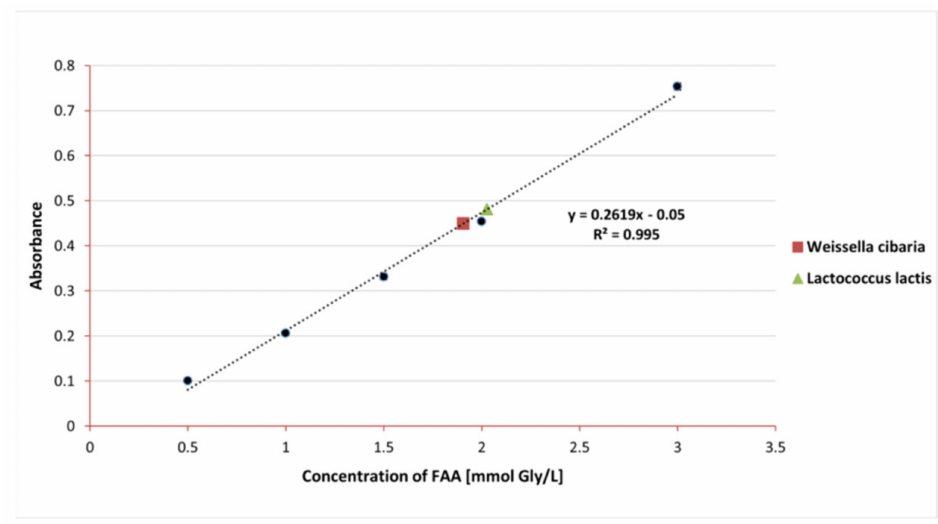
Figure 3. Calibration curve showing the dependence of absorbance on the concentration of